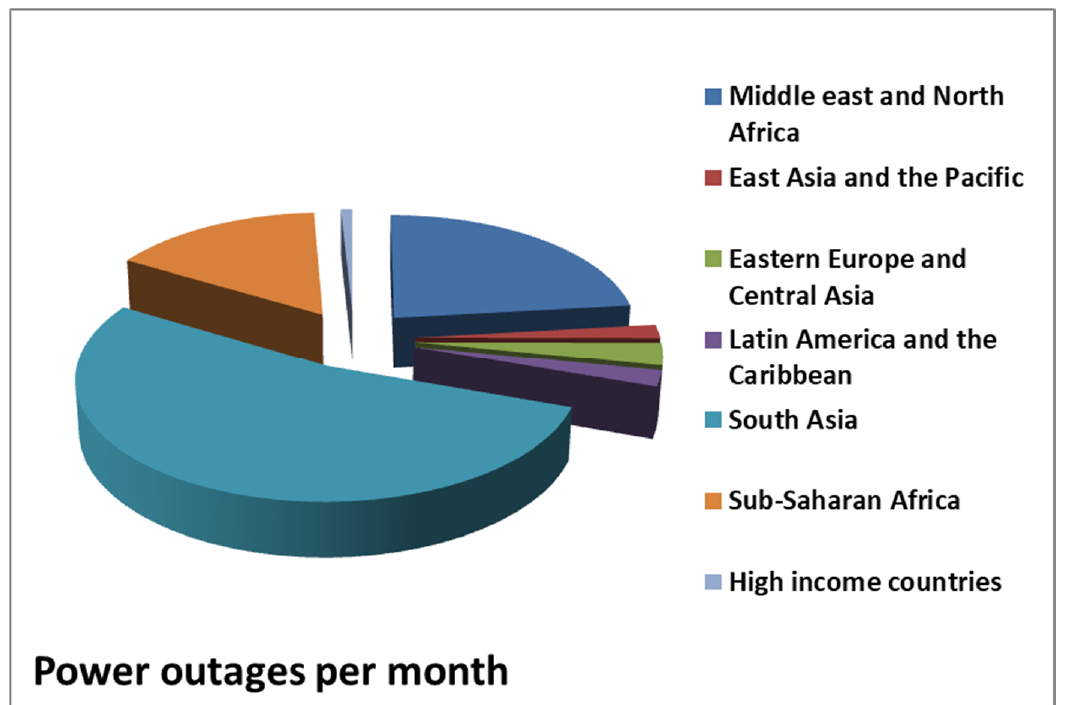
Figure 1. Global power outages per month (The World Bank’s Enterprise Surveys (WBES) database 2005–2016) [9].